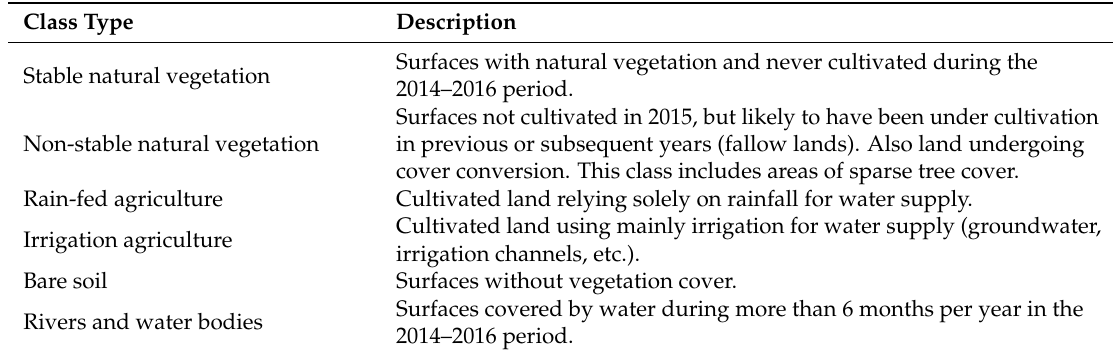
Table 1. Description of mapped classes.